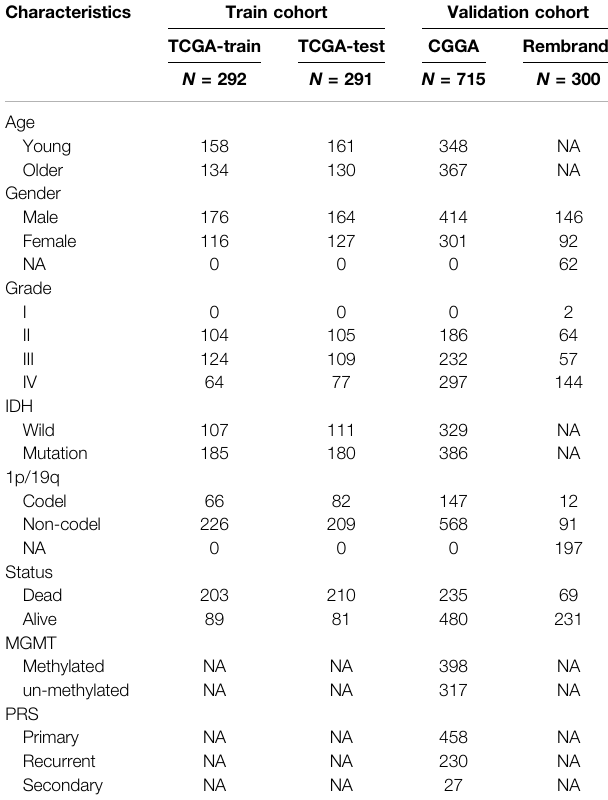
TABLE 1 | Clinicopathological characteristics of glioma patients in TCGA, CGGA, and REMBRANDT